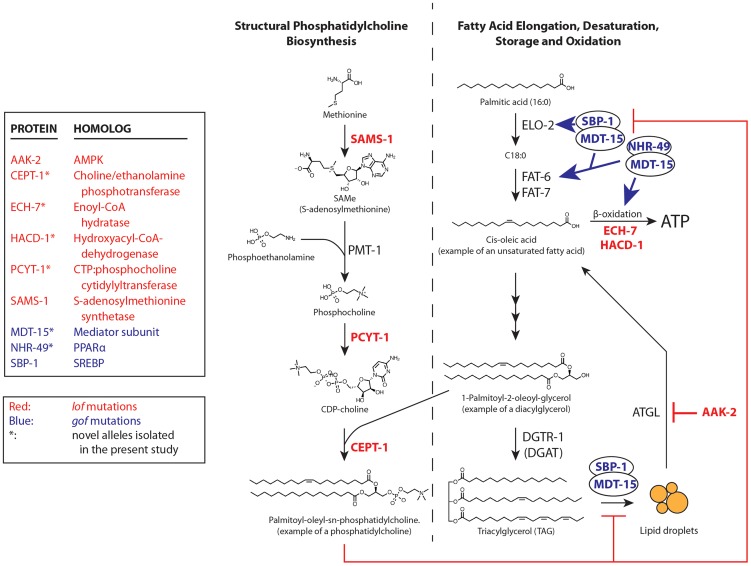

paqr-2 suppressors either inhibit phosphatidylcholine synthesis or promote fatty acid metabolism.Red- and blue-labeled names indicate proteins where lof and gof alleles can suppress the paqr-2 phenotypes, respectively; for sbp-1 we used a multicopy transgene as a gof allele. The nhr-80(tm1011) lof allele also suppresses the paqr-2 cold adaptation defect [12]; it is omitted from the figure for clarity.